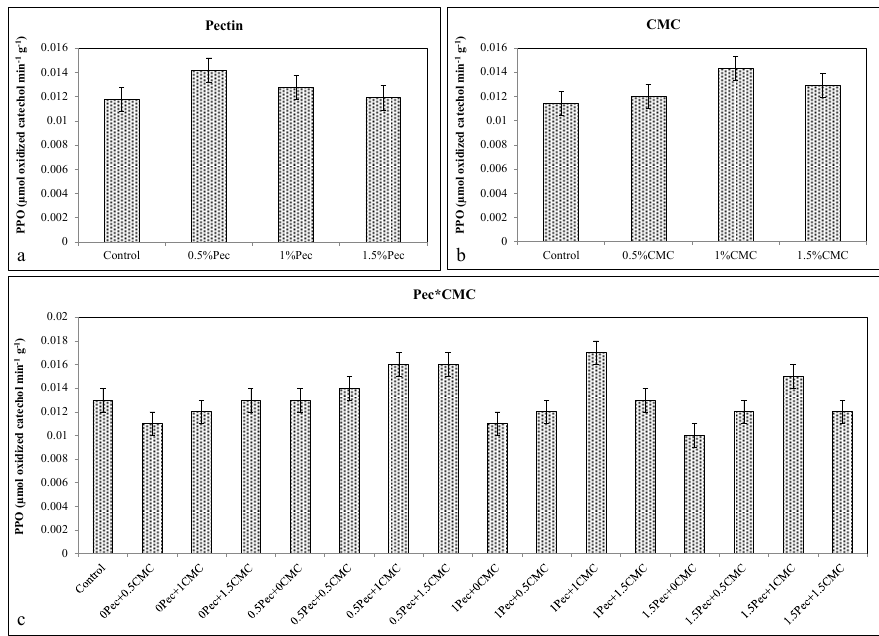
Figure 11. Effect of 0 (control), 0.5 (0.5% Pec), 1 (1% Pec) and 1.5 (1.5% Pec) % pectin-based edible coatings ( a ), 0 (control), 0.5 (0.5% CMC), 1 (1% CMC) and 1.5 (1.5% CMC) % carboxymethylcellulose-based edible coatings ( b ) and their combinations ( c ) on polyphenol oxidase (PPO) enzyme activity during cold storage period. Data are the “estimated marginal means ±95% confidence intervals”. The results were expressed on a fresh weight basis. The columns with non-overlapping error bars are significantly different ( p ≤ 0.05).